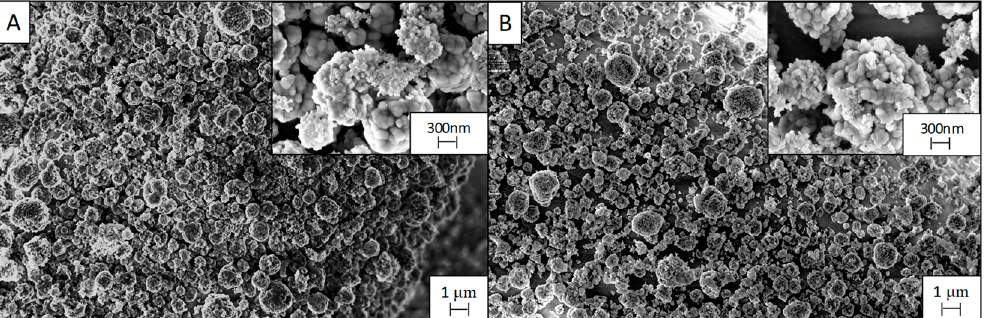
Figure 10. SEM images of the PD20-P coating before ( A ) and after ( B ) the five use cycles; the images were acquired at 10kx magnification, while the insets were acquired at 50kx.